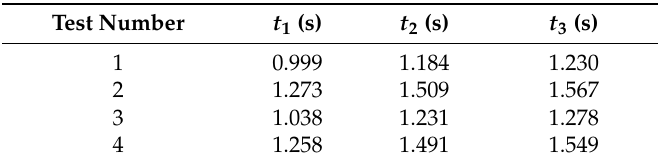
Table 5. Time of bump between axles and joint.